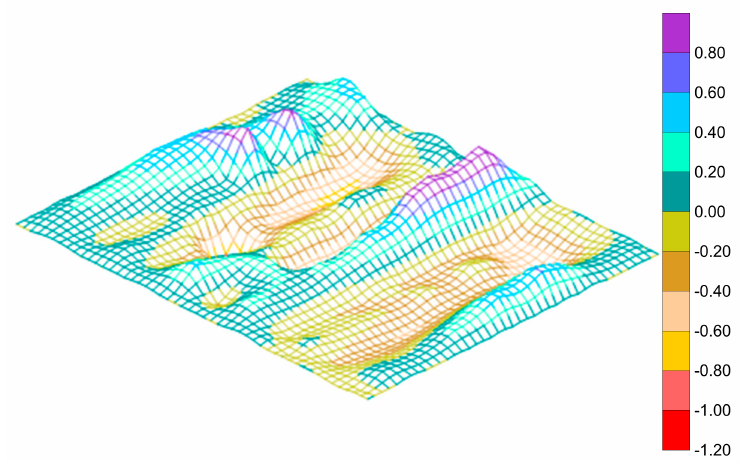
Figure 7. Imperfection profile of specimen LSTP1.